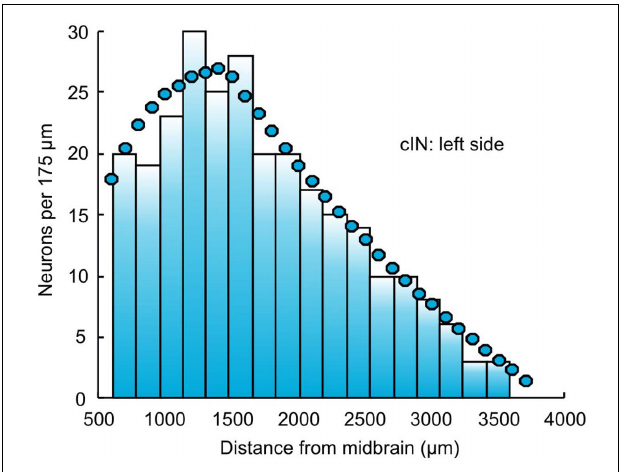
FIGURE 2 |The distribution of cIN neurons along the left side of the body. Bars indicate the connectome distribution (bin width is 175 μ m); circles indicate the experimental